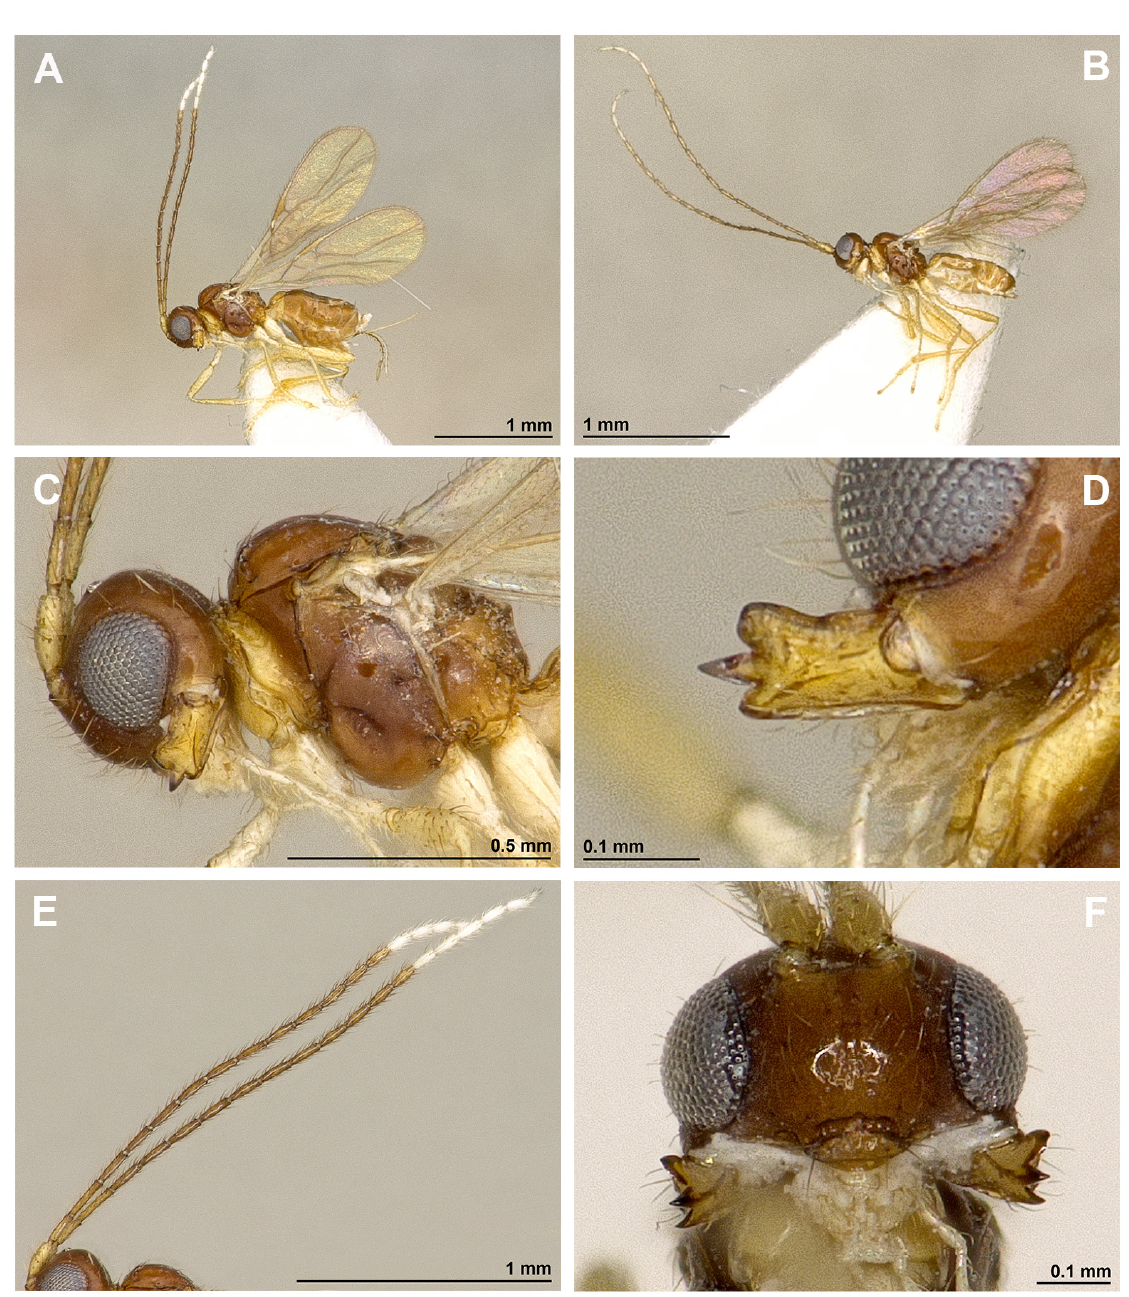
Fig. 5. Asobara caboverdensis van Achterberg, sp. nov., A, C–F: ♀, holotype (RMNH); B: ♂. (RMNH) A–B . Habitus, lateral view. C . Head and mesosoma, lateral view. D . Mandible. E . Antenna. F . Head, front